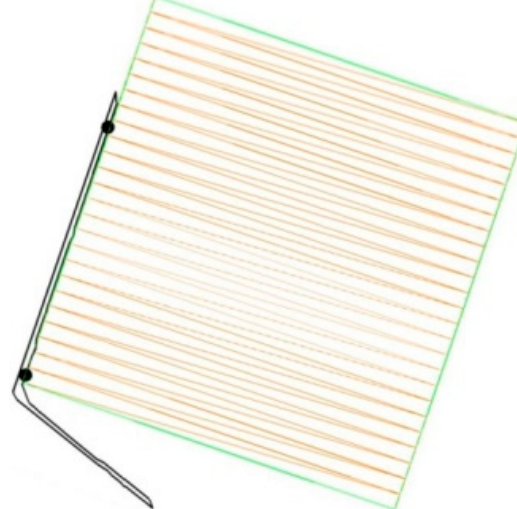
Figure 9. Quay wall model extracted from a point cloud. Black dots show the position of the LiDAR sensors. Polygon on the left shows the extracted quay wall shape. Orange boxes show the location and box filter of the defined vertical Reference Point filters. Additional horizontal Reference Point is marked as green rectangle.